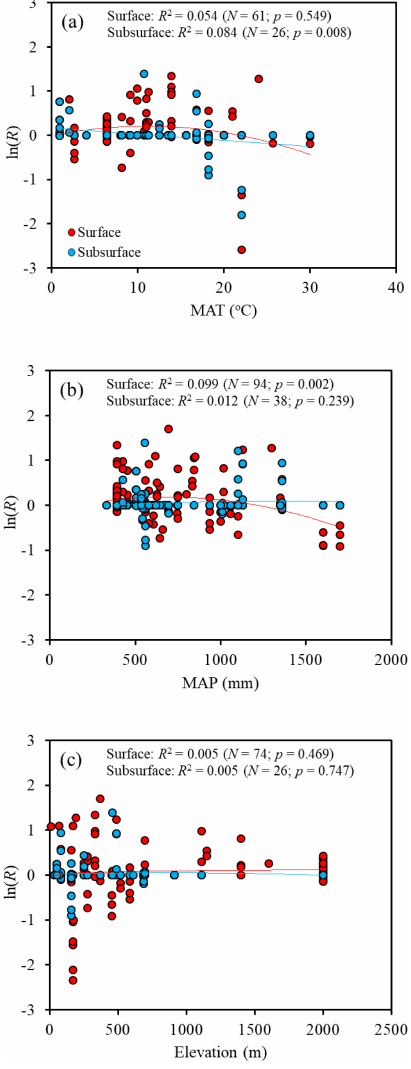
Figure 4. Relationships between the natural logarithm of the re- sponse ratio (ln( R )) for soil saturated hydraulic conductivity under conservation tillage with the (a) mean annual temperature (MAT), (b) mean annual precipitation (MAP), and (c)